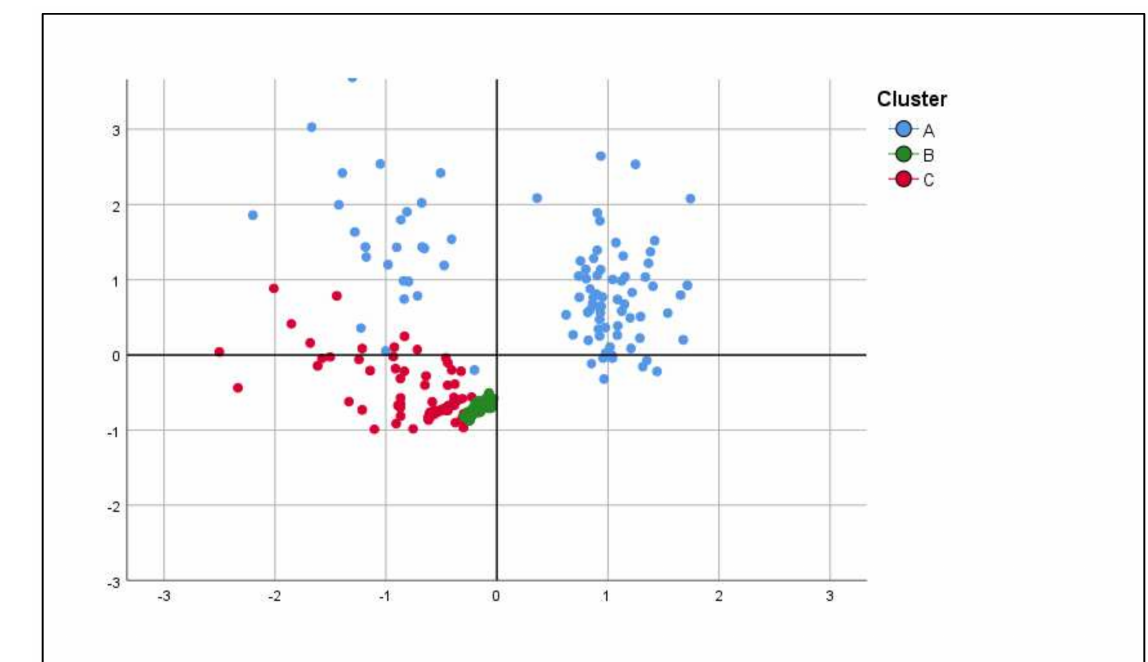
Figure 1. Factor map of the Principal Component Analysis showing the distribution of each patient in each